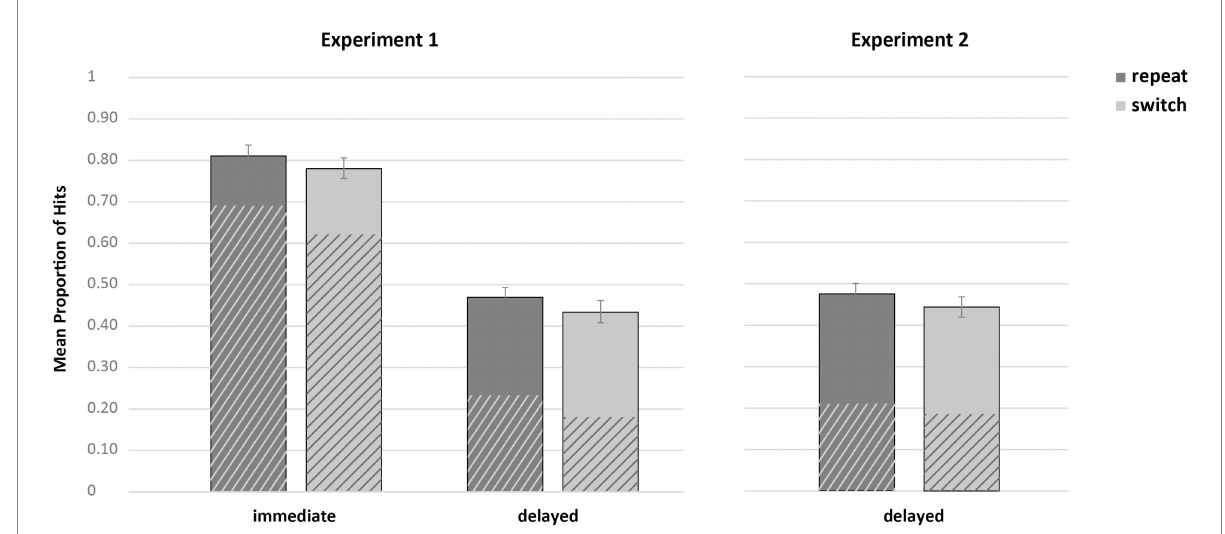
FIGURE 2 Results of Experiment 1 (left) and Experiment 2 (right), depicted as Hits, separated by remember (shaded area) and know judgements (solid area). The error bars represent standard